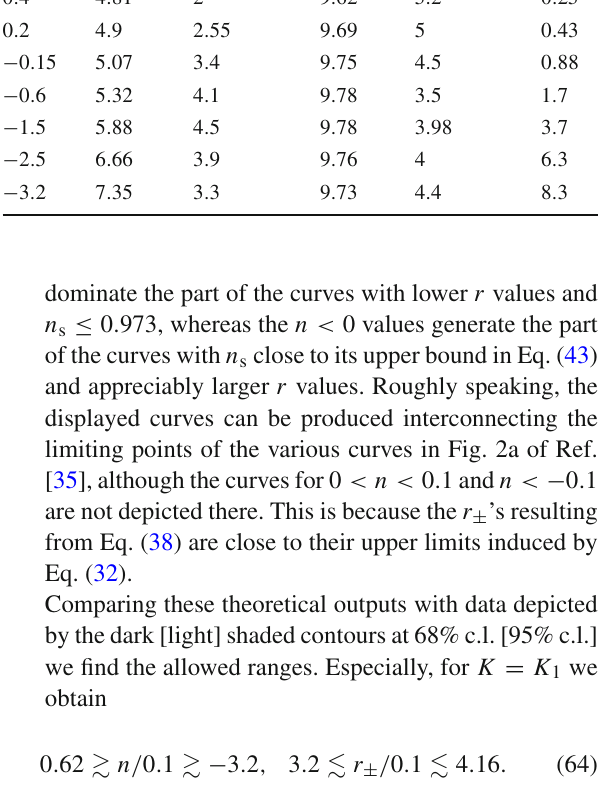
(cid:12) V HI changes drastically. To illuminate this fact ture of (cid:12) V HI as a function of φ in Fig. 4 for K = K 2 we show or K 3 , n = 0 . 02 (gray line) and n = − 0 . 25 (light gray line). We take in both cases φ (cid:14) = 1. Therefore, the cor- responding c − and λ values are confined to their lowest possible values enforcing Eqs. (41a) and (41b).